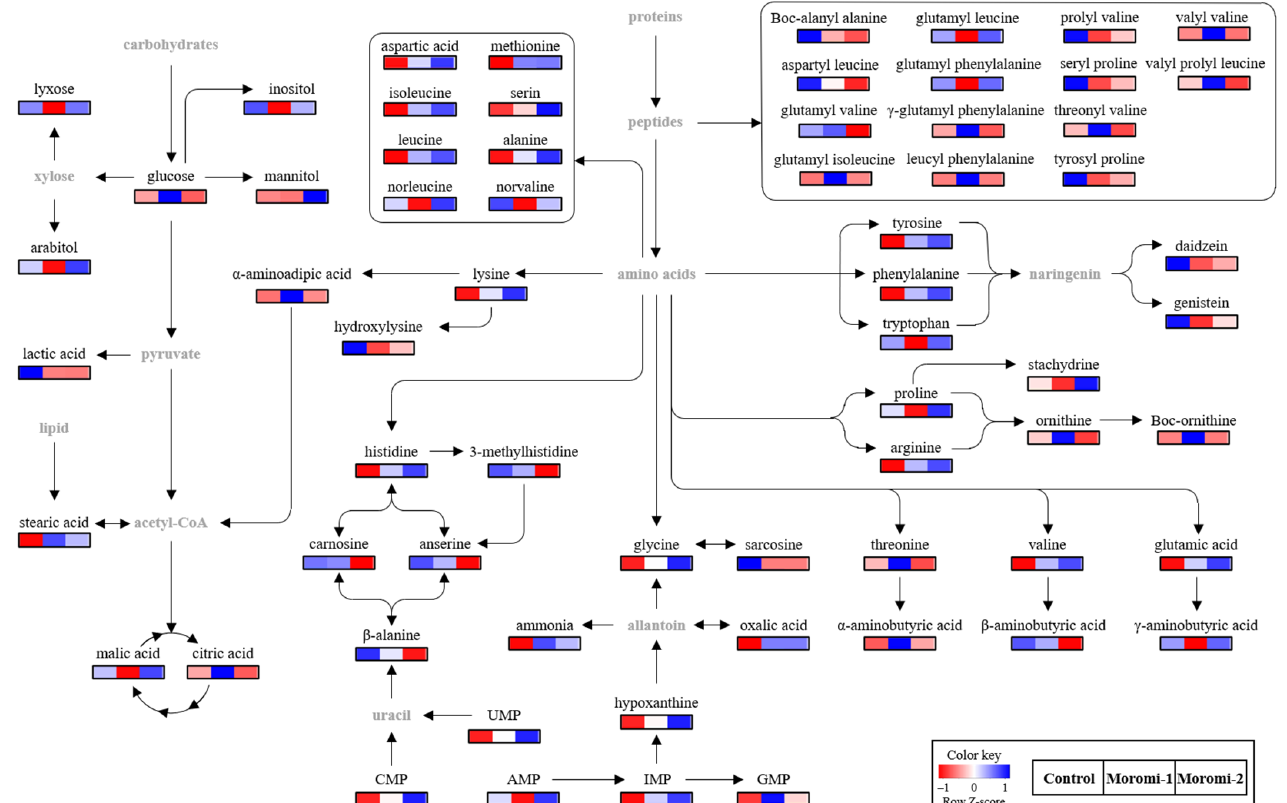
Figure 4. Proposed pathway related to A . oryzae fermentation. Control, moromi-1, and moromi-2 are moromi samples fermented by commercial strain, A. oryzae KCCM13012P, and A. oryzae KCCM12804P, respectively. The heat maps showed the relative abundance of identified metabolites. Blue and red indicate the increase and decrease in metabolite levels, respectively. CMP, cytidine monophosphate; UMP, uridine monophosphate; GMP, guanosine monophosphate; IMP, inosine monophosphate; AMP, adenosine monophosphate.